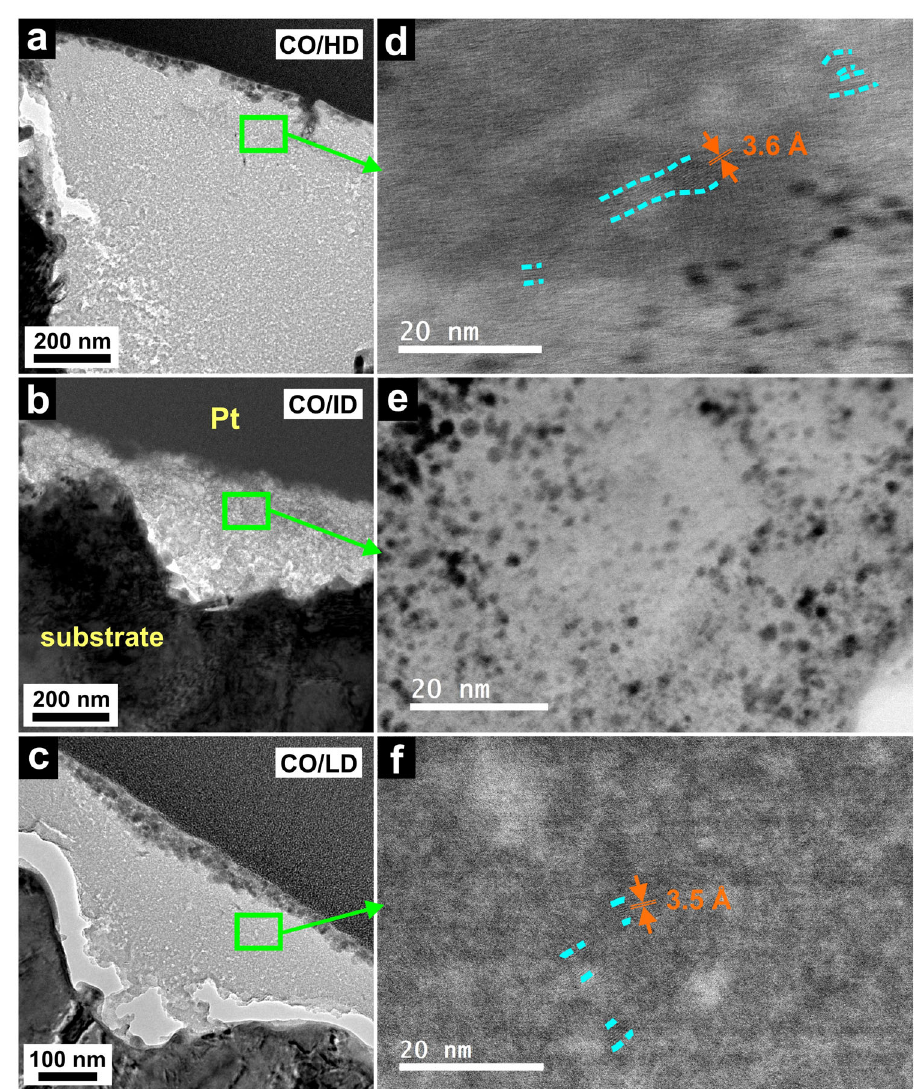
Fig. 7 Post friction test, cross-sectional TEM images of the CO coatings. Representative images of the tribo fi lm at lower magni fi cation on a HD, b ID, and c LD. The gap between the substrate surface and tribo fi lm in ( c ) is a consequence of sample preparation. Representative images of the tribo fi lm close to the interface at higher magni fi cation on d HD, e ID, and f LD. Identi fi able crystalline fragments are contoured in